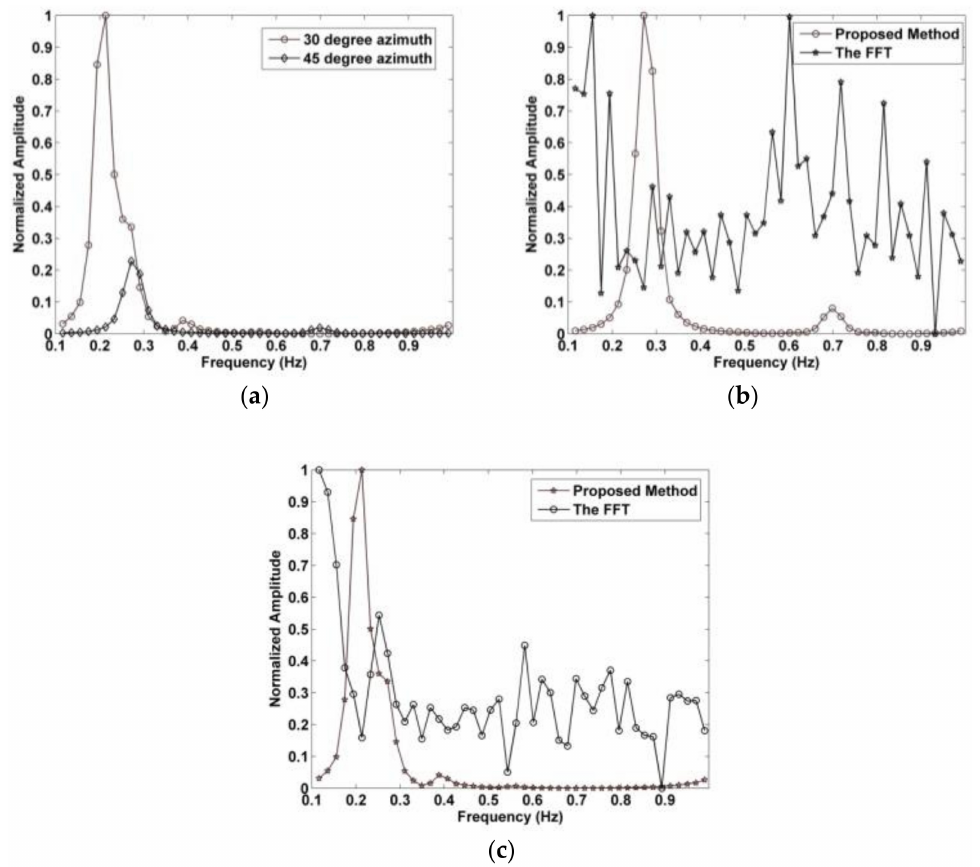
Figure 20. The normalized respiration spectrum with ( a ) 30 ◦ and 45 ◦ azimuth angles using the proposed method, ( b ) the proposed and FFT methods at 45 ◦ azimuth angle, and ( c ) the proposed and FFT methods at 30 ◦ azimuth